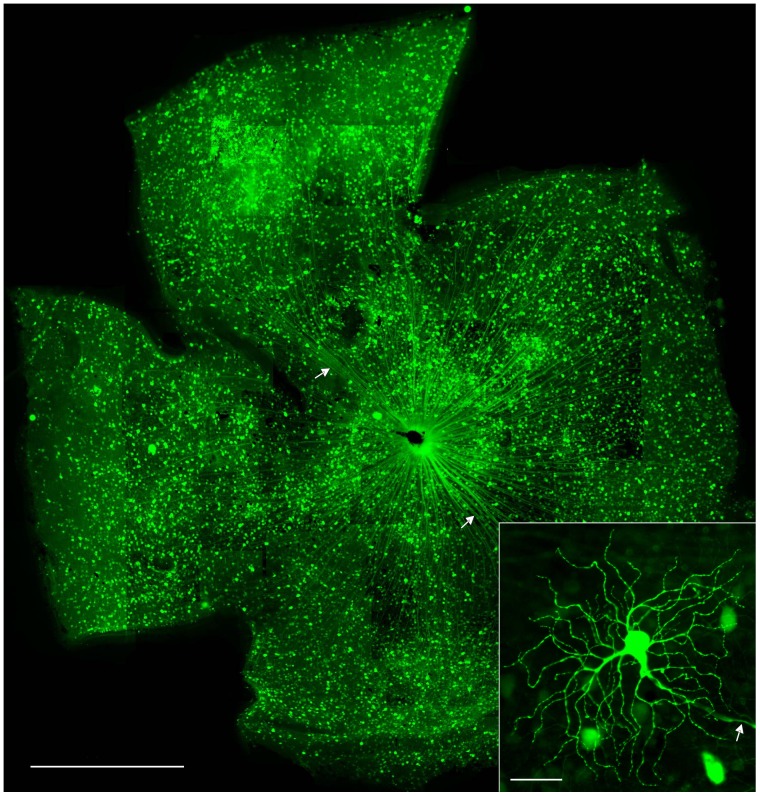
Transduction of retinal ganglion cells (RGCs) in rd1 mice following intravitreal administration of an adeno-associated virus (AAV) vector carrying the gene for enhanced green fluorescent protein (EGFP).Representative retinal flat mount shows extensive GFP expression throughout the whole retina. Some GFP expressing cells have the size and dendritic morphology of RGCs and possess an axon leading from the cells to the optic disc (arrows), indicative of RGCs. The entire dendritic tree structure of some RGCs is clearly visualized by GFP expression (inset). Scale bars, 1 mm (100 µm in inset).